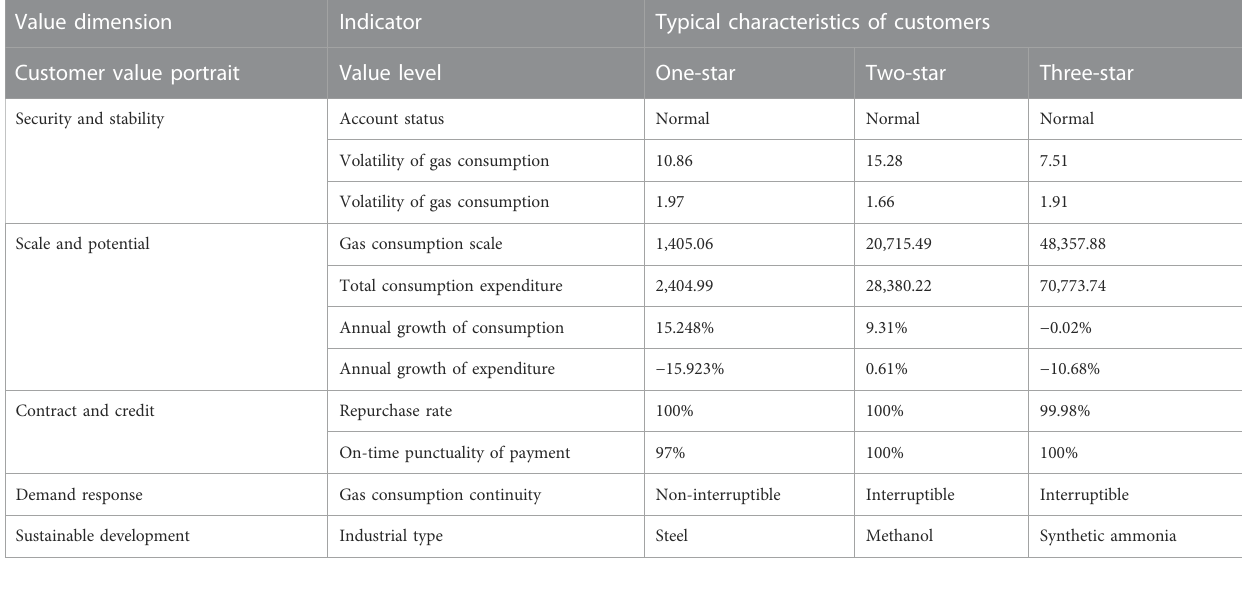
TABLE 2 Typical characteristics of different customers ’ value.